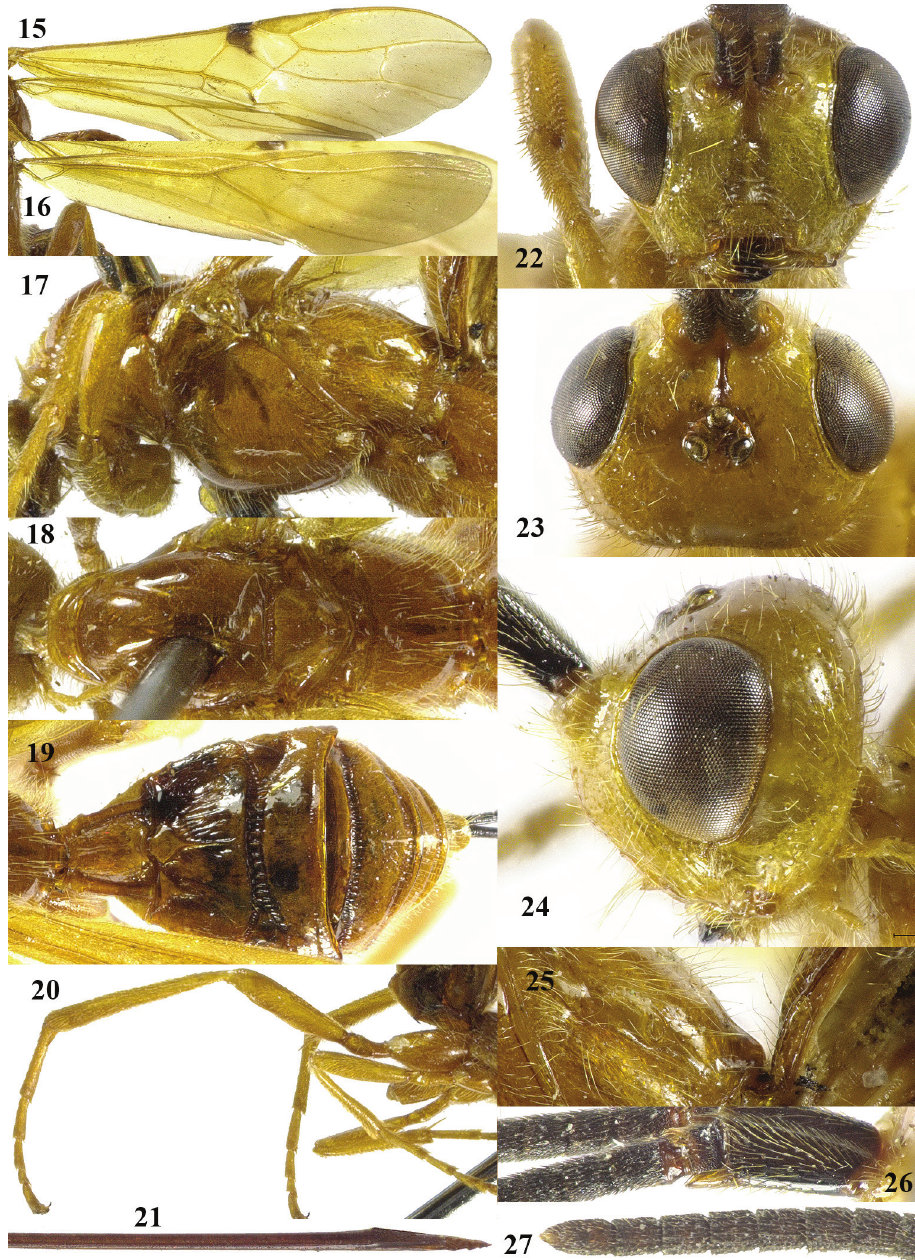
Figures 15–27. Craspedolcus fraternus Enderlein, ♀ , China (Yunnan). 15 fore wing 16 hind wing 17 mesosoma lateral 18 mesosoma dorsal 19 metasoma dorsal 20 hind leg lateral 21 apex of ovipositor lateral 22 head, anterior 23 head, dorsal 24 head lateral 25 propodeum lateral 26 scapus outer side lateral 27 apex of